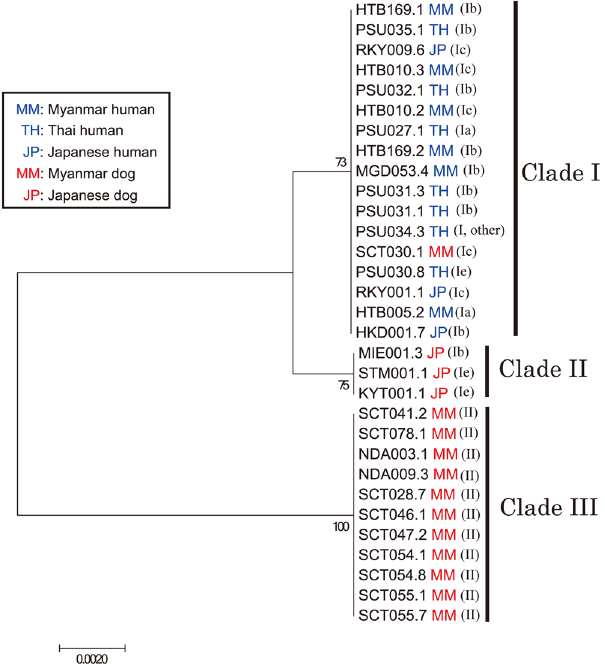
Figure 4. Maximum-likelihood tree built for selected Strongyloides isolates using a portion of a nuclear major sperm protein domain-containing protein (MSP) gene. MEGA7 software was used to build the tree using a dataset of MSP gene (551 bp) based on the Tamura-Nei model. Two-letter codes next to the isolate names indicate types of hosts from which those were isolated. Letters inside the brackets indicate the Cox1 clade to which each isolate